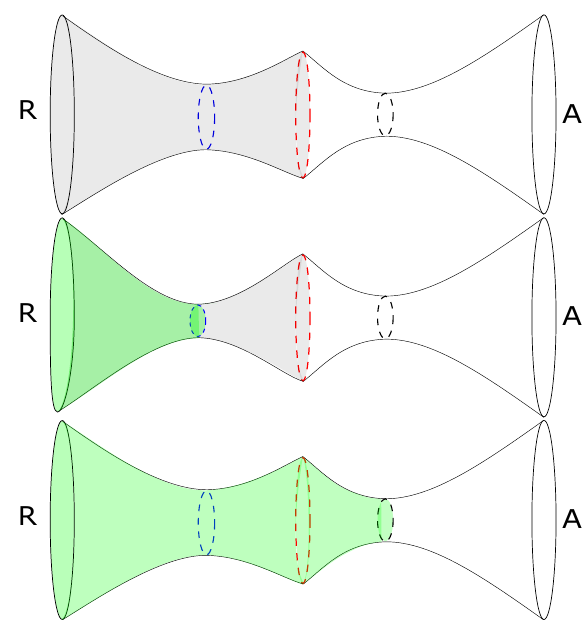
Figure 6 . Top: the puri(cid:12)cation of (cid:12)gure 1c. The auxiliary radiation system (the reservoir) is identi(cid:12)ed with a new asymptotic boundary R in the inception geometry. Middle: the entanglement wedge (green) of the radiation before the Page time when the entropy of the inception black hole is smaller than the entropy of the real black hole. Bottom: the entanglement wedge (green) of the radiation after the Page time when the entropy of the inception black hole is greater than the entropy of the real black